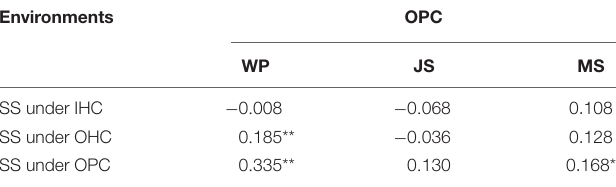
TABLE 4 | Correlation coefficients of RDW between SS and other